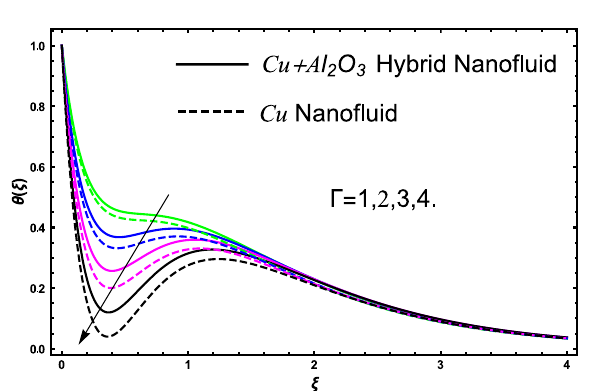
Figure 4. The fluctuation produces in the velocity f